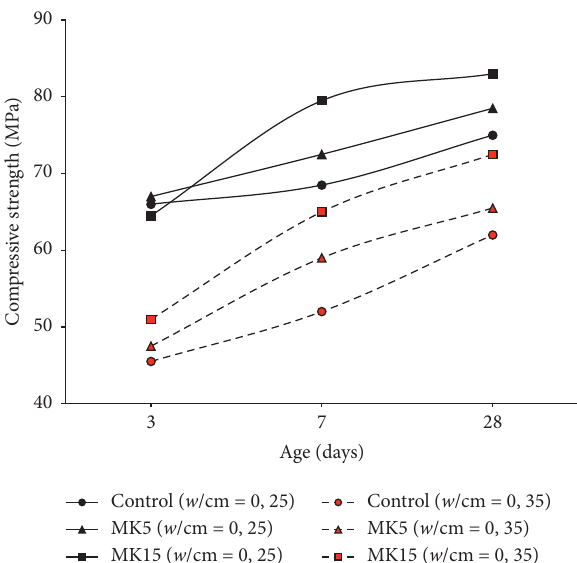
Figure 6: Effect of admixtures on compressive strength develop- ment in concrete